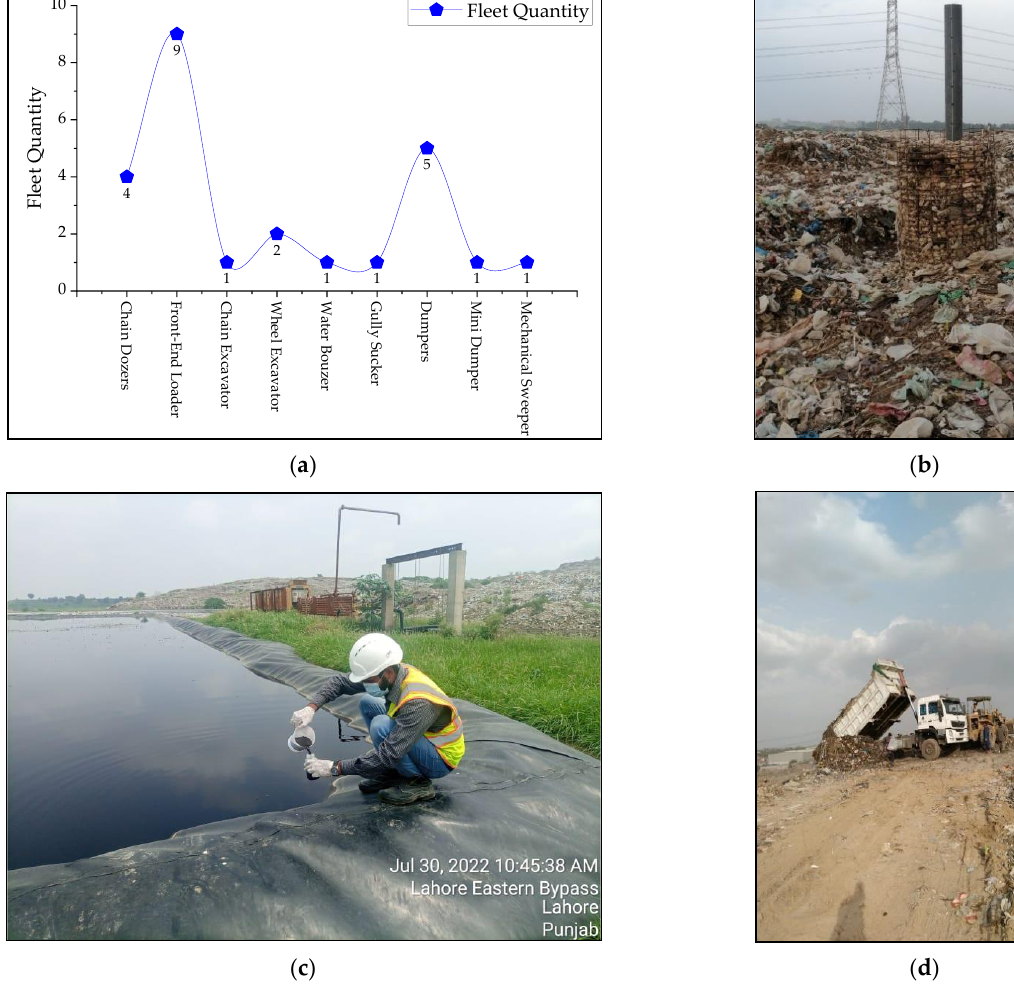
Figure 16. Fleet and infrastructure at LFS: ( a ) Quantity of fleet deployed at Lakhodair site for waste handling; ( b ) Gas vents installed at the site; ( c ) Leachate pond at site; ( d ) Waste handing operation at the site.